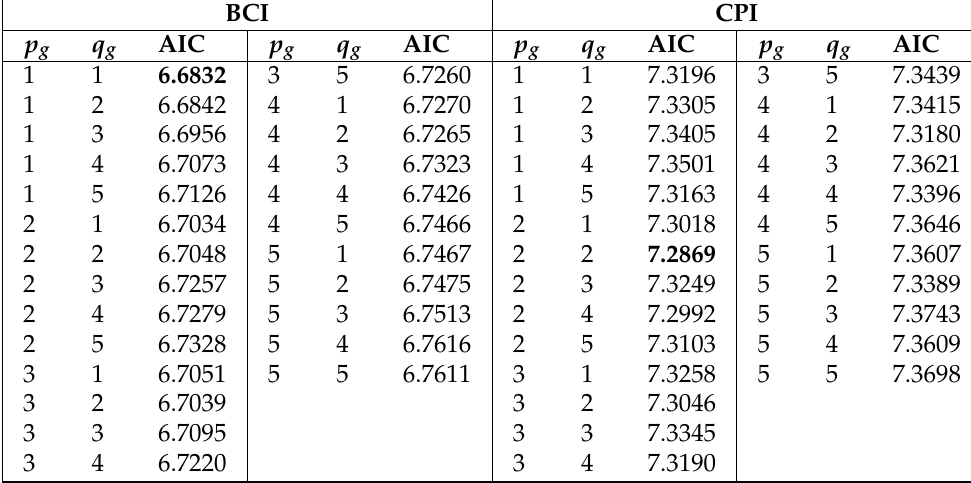
Table 4. AIC for ARMA-TGARCH models fitted to BCI and CPI time series. The bold entries highlight the smallest AIC values for each